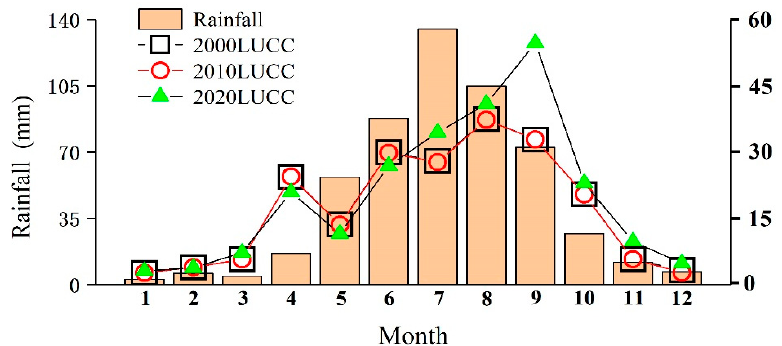
Figure 20. Annual total phosphorus monthly loadings under three land use phases.